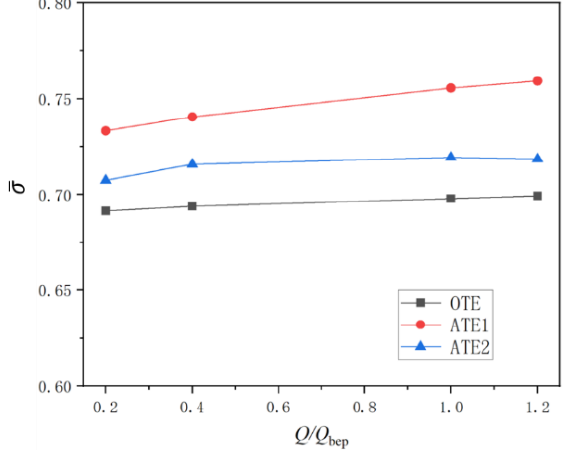
Figure 14. The average slip factors at R/R 0 = 1.0.